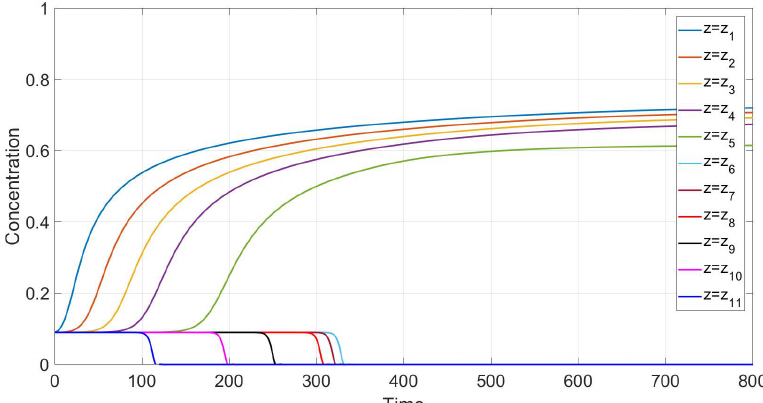
Figure 15. Calculated values of concentration versus time at different vertical locations for the flux F rz . There is monotonicity with the initial and boundary data c 0 = 0.09, c bot = 1, c top =